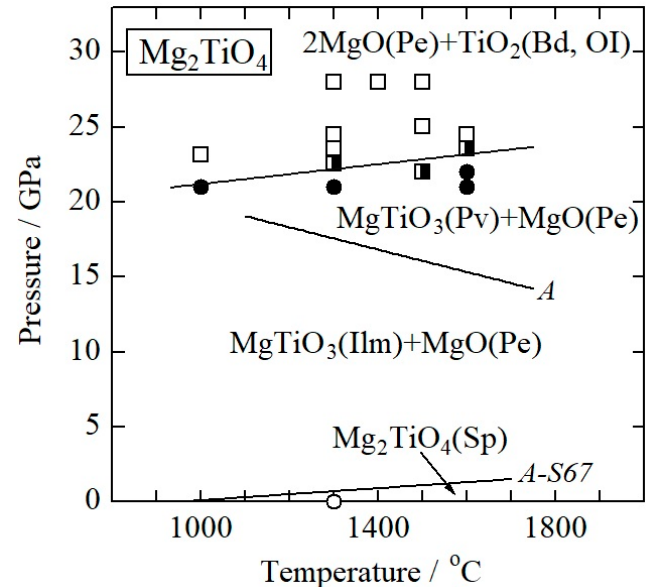
Figure 2. Phase diagram of Mg 2 TiO 4 . An open circle: Mg 2 TiO 4 (Sp), solid circles: MgTiO 3 (Pv) + MgO(Pe), open squares: 2MgO(Pe) + TiO 2 (Bd, OI). A thick solid line: this study, a thin line with A-S67: Sp dissociation boundary to Ilm + Pe [7], a thin line with A: Ilm-Pv boundary [25]. Sp: spinel-type, Ilm: ilmenite-type, Pe: periclase, Pv: perovskite-type, Bd: baddeleyite-type, OI: orthorhombic I-type. Table 2. Using the data in Table 2, for the following transitions in Mg 2 TiO 4 : Mg 2 TiO 4 (Sp) → MgTiO 3 (Ilm) + MgO(Pc) → MgTiO 3 (Pv) + MgO(Pc) → 2MgO(Pc)